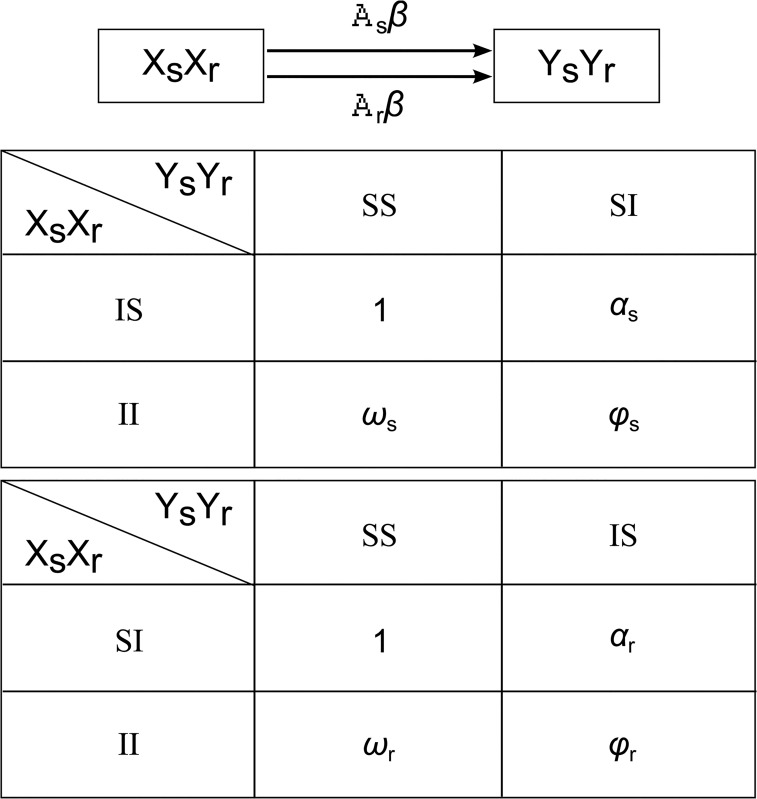
Transmission mechanism for treatment-sensitive and treatment-resistant gonorrhoea as implemented in the model.Xs, Xr denote the infection status of person X: Xs = S if X is susceptible to treatment-sensitive gonorrhoea; Xs = I if X is infected with treatment-sensitive gonorrhoea. Similarly, Xr = S or Xr = I if X is susceptible or infected with treatment-resistant gonorrhoea, respectively. The diagram represents transmission from person X to person Y through unprotected sex act (transmission from Y to X is omitted in this diagram). The parameter β is the transmission probability per unprotected sex act. The parameters A
s and A
r are scalar adjustment to the transmission probability for treatment-sensitive and treatment-resistant gonorrhoea, respectively, and their value will be based on the infection status of person X and person Y as defined in the figure. A
s and A
r are equal to zero for all combinations not listed.